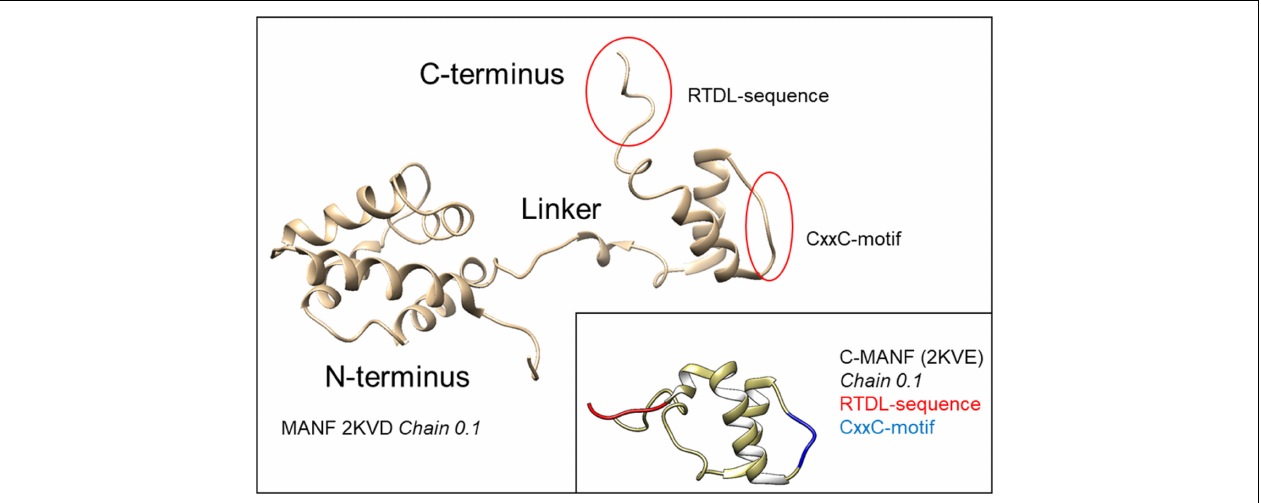
FIGURE 1 | Structure-function relationship of mesencephalic astrocyte-derived neurotrophic factor (MANF). The figure is based on the NMR structures of MANF and C-MANF (Hellman et al., 2011) (PDB codes: 2KVD and 2KVE, respectively. Image created with Chimera 1.16). The C-terminal RTDL-sequence of MANF corresponds to the canonical ER-retrieval signal